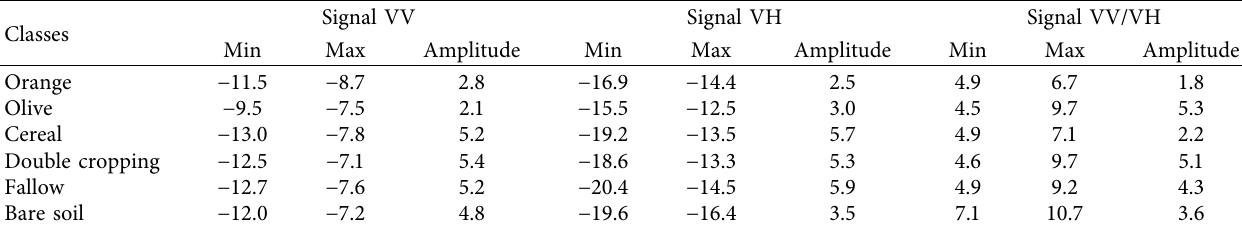
Table 3: Minimum values, maximum values, and amplitudes of the VV, VH, and VV/VH signals for the different classes. Classes